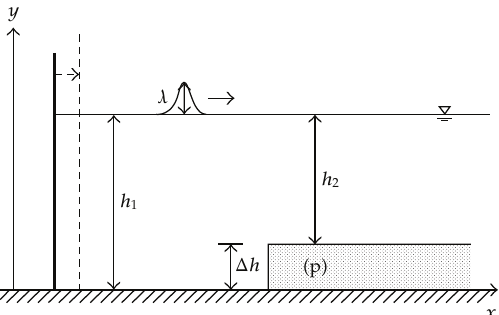
Figure 5: Schematic diagram of a solitary wave propagating over a discontinuity